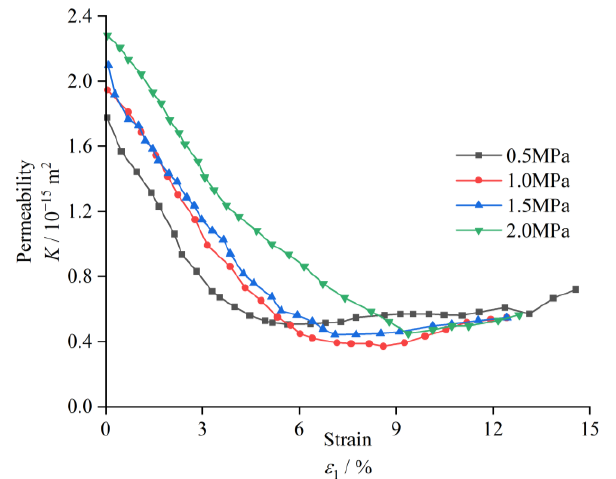
Figure 8. The permeability characteristic curve of coal sample under axial compression loading under a constant confining pressure of 4 MPa and different gas pressures.